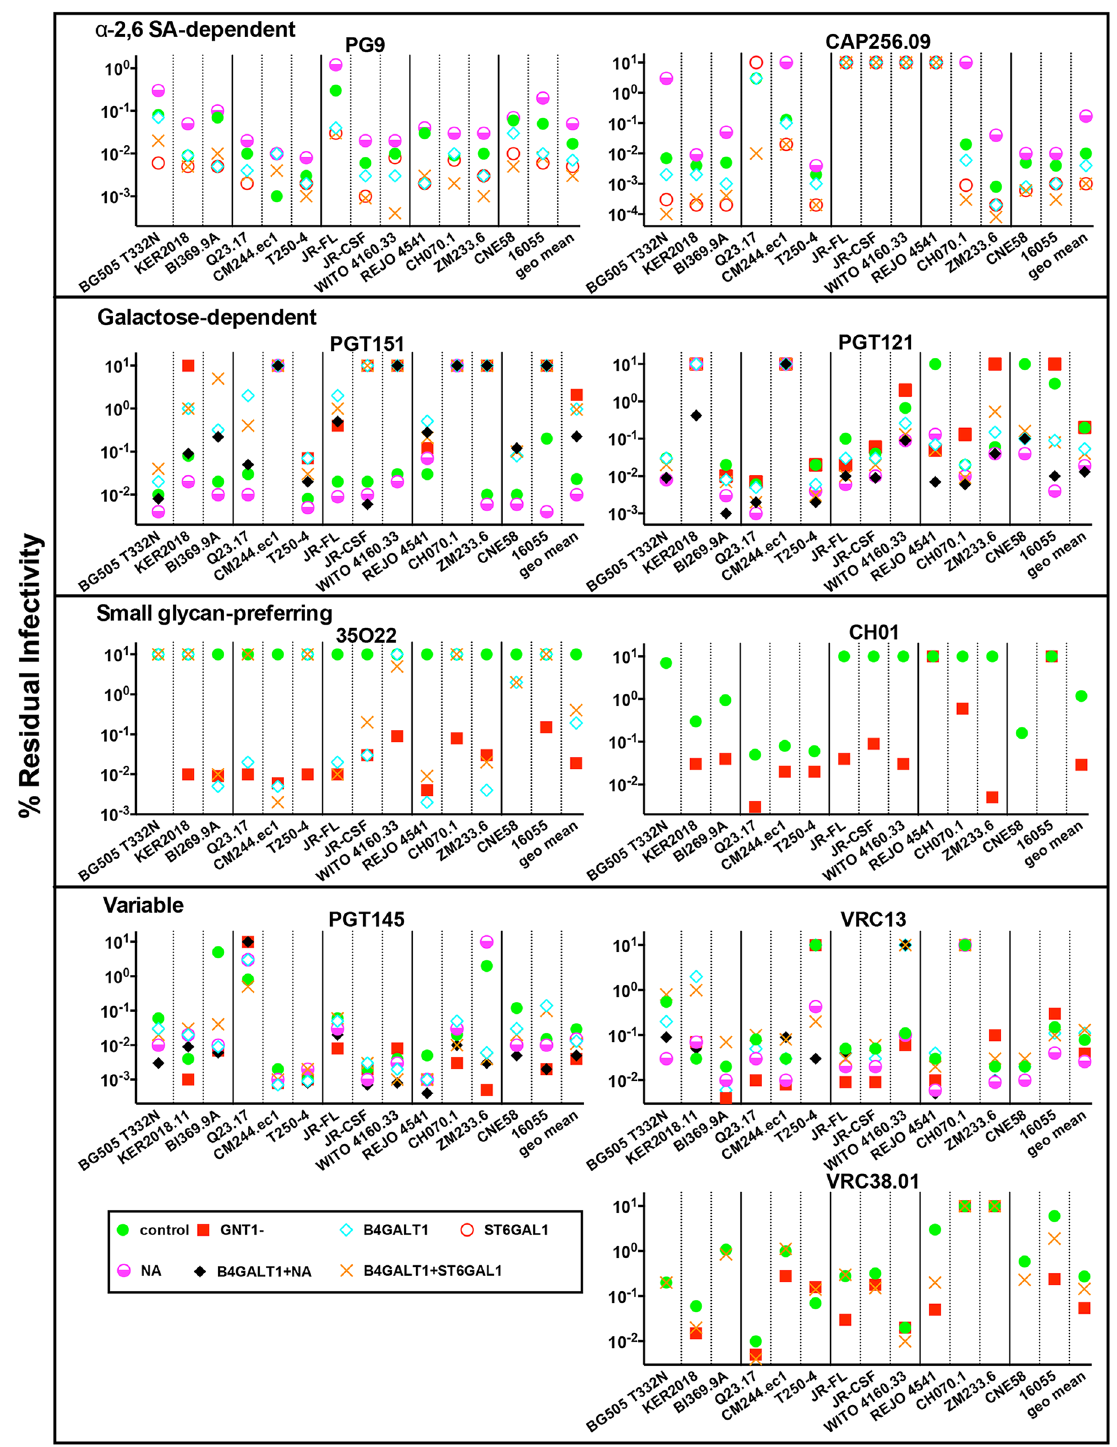
Fig 5. GE effects on the neutralization sensitivities of a diverse panel of virus strains. The effects of various GE modifications on mAb IC50s against a panel of 14 viruses are shown. Particular GE modifications for each nAb were selected as those that markedly affect neutralizing activity against the JR-FL and/or the BG505 strains above. IC50s > 10ug/ml were assigned as 10μg/ml. Geometric mean IC50s of all 14 viruses per each GE treatment are shown on the right of each chart, omitting datum for mAb-virus combinations in which IC50s were > 10μg/ml under all GE conditions. The infectivities of GNT1- modified BG505 and CNE58 were too low for IC50s to be reliably